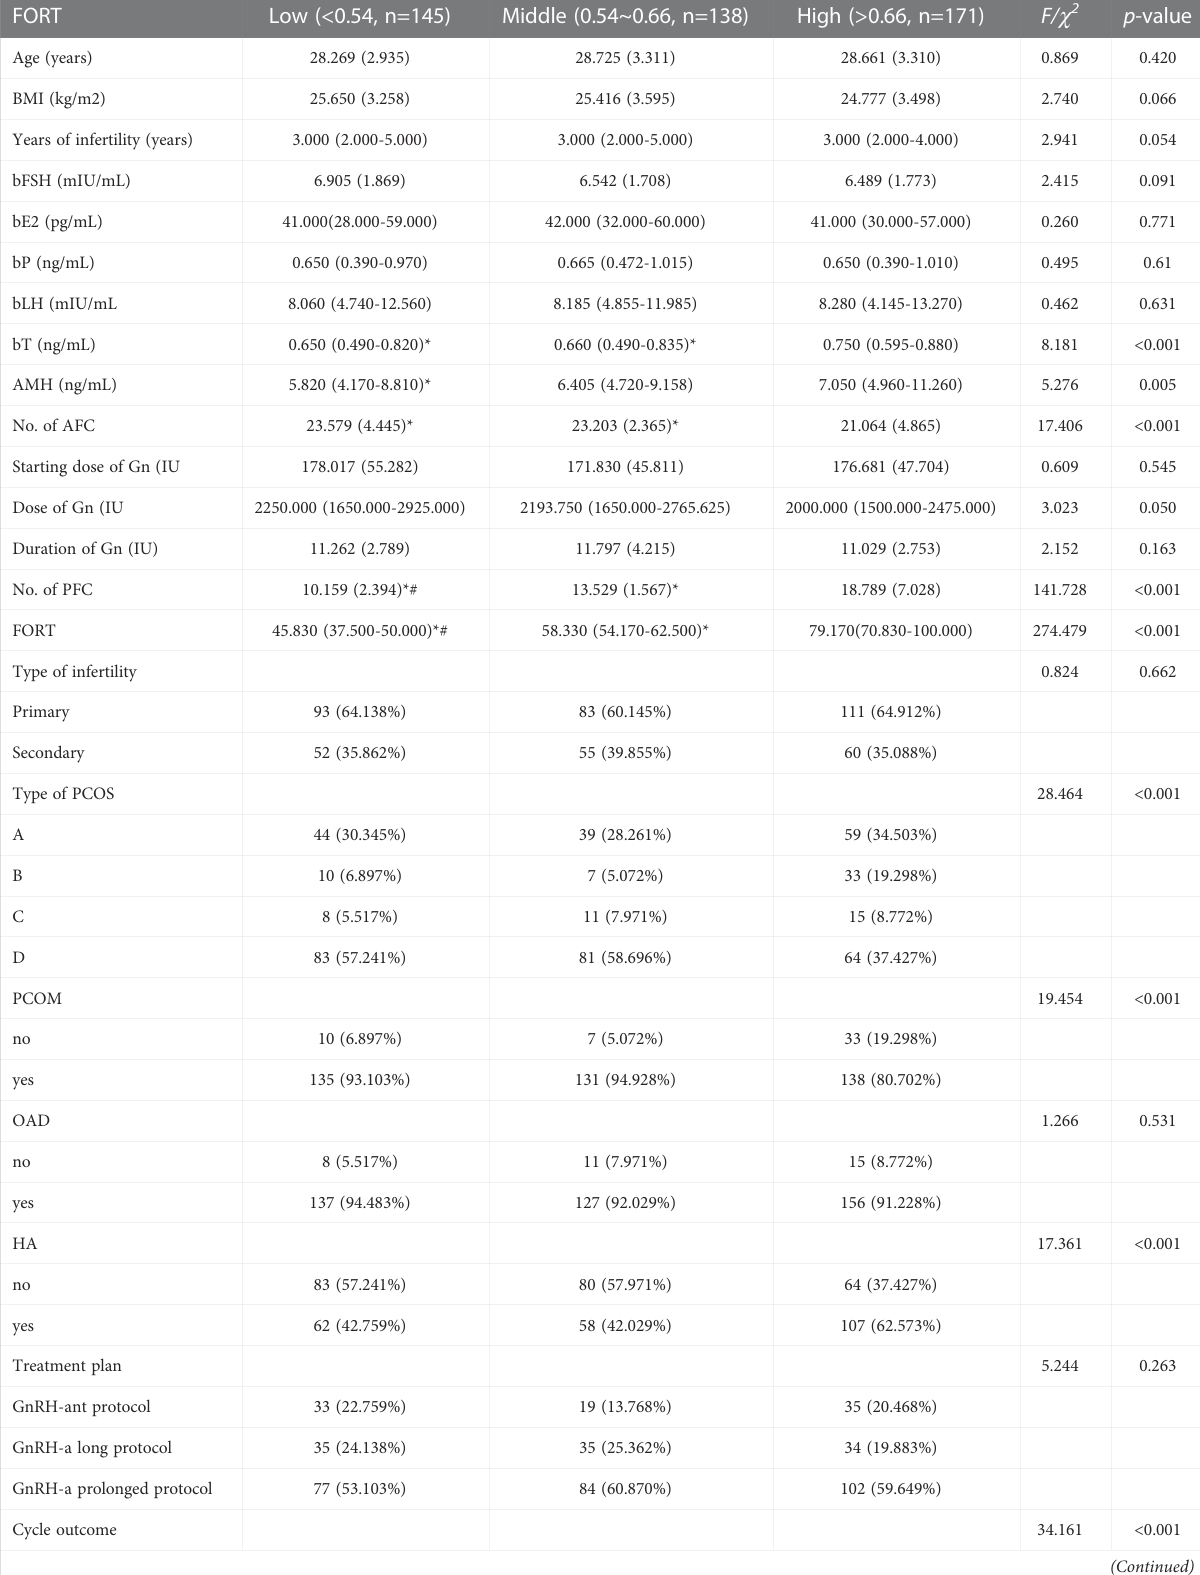
TABLE 1 Patient ’ s baseline